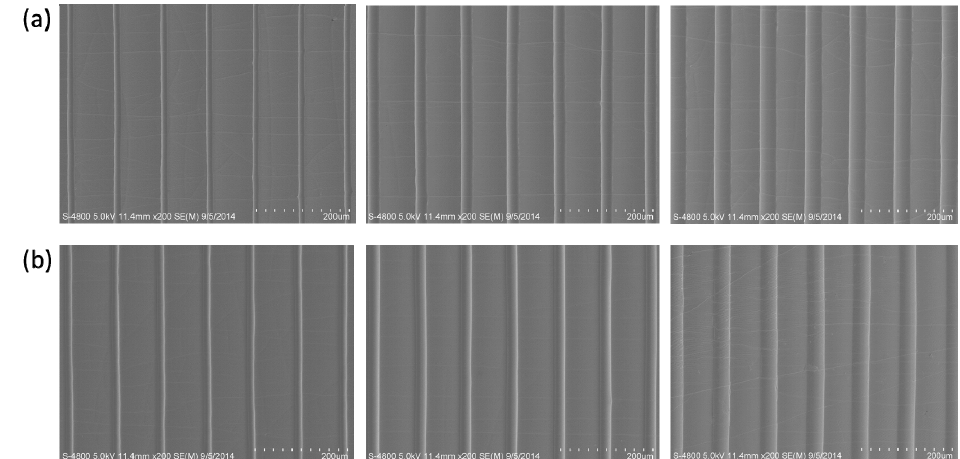
Figure 4. Morphologies of etched line templates and the microstructured surface with raised line based on multilayer inkjet-printed microtemplates. ( a ) The etched templates with different inkjet printing layers (1, 3, 5 layers from left to right). ( b ) The replicated microstructures with different inkjet printing layers (1, 3, 5 layers from left to right).